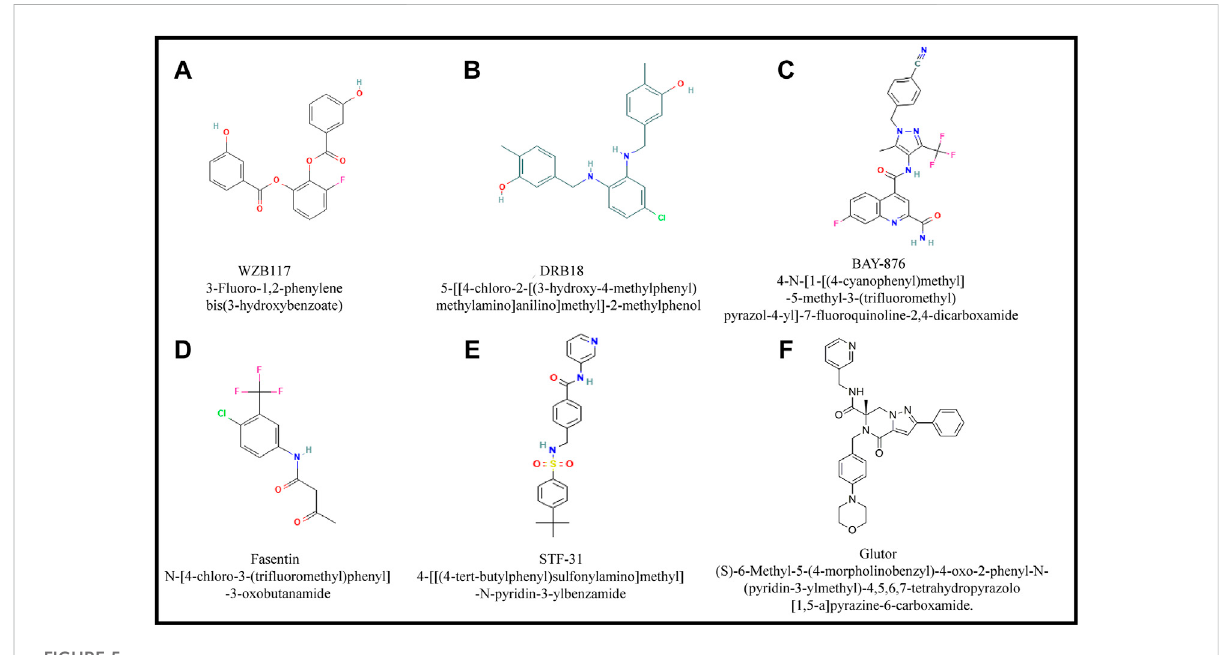
FIGURE 5 Major small inhibitory molecules of GLUTs. Figures (A-F) show structural details of small GLUT inhibitory molecules. Most of these molecules have overall common structural organization except few alterations in ring structure, constituent elements and their